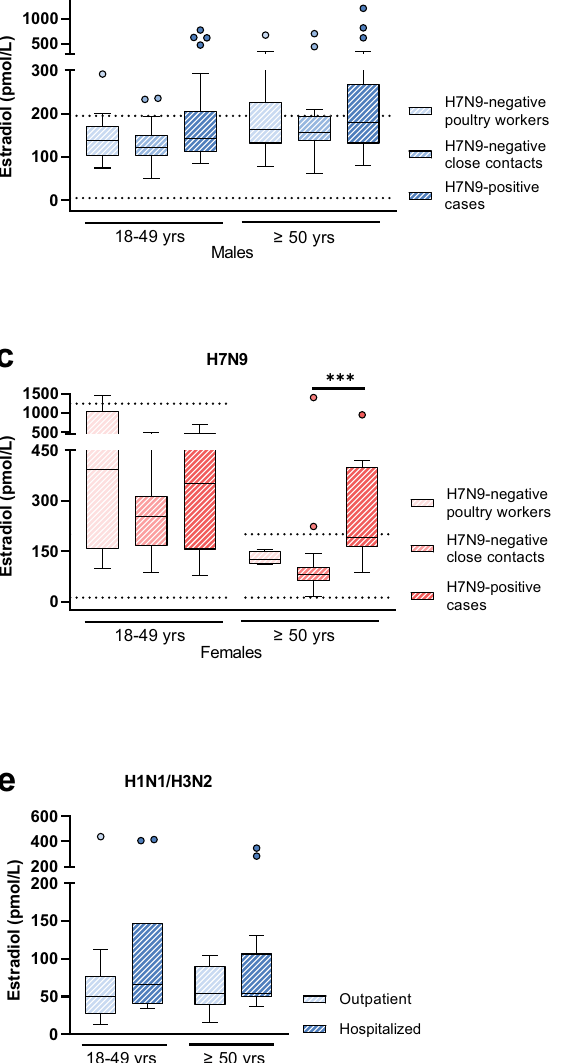
patients (18 – 49yrs outpatient/hospitalized: n =12/4, ≥ 50yrs outpatient/hospita- lized: n =13/10) ( f ) and are compared in dependency of disease outcome (out- patientvs.hospitalization).Theage-speci fi creferencerangeofestradiolinChinese men and women was added as dotted lines in ( a ) and ( c ) (no age difference in estradiol in Chinese men) 39 . a – f Data are presented as Box-and-whisker plots (Tukey). The horizontal line in each box represents the median value. The 25th – 75th percentiles represent the endpoints of the box. The whiskers stretch to thelowestandhighestvalueswithin1.5timestheinterquartilerange(IQR)fromthe 25th – 75th percentiles. Dots represent outliers according to Tukey ’ s de fi nition. Unpaired, two-tailed non-parametric analysis (Mann – Whitney test) was used for comparisons between two groups. The Kruskal – Wallis test was used for compar- isons among the three groups. P values were classi fi ed into four groups: * p